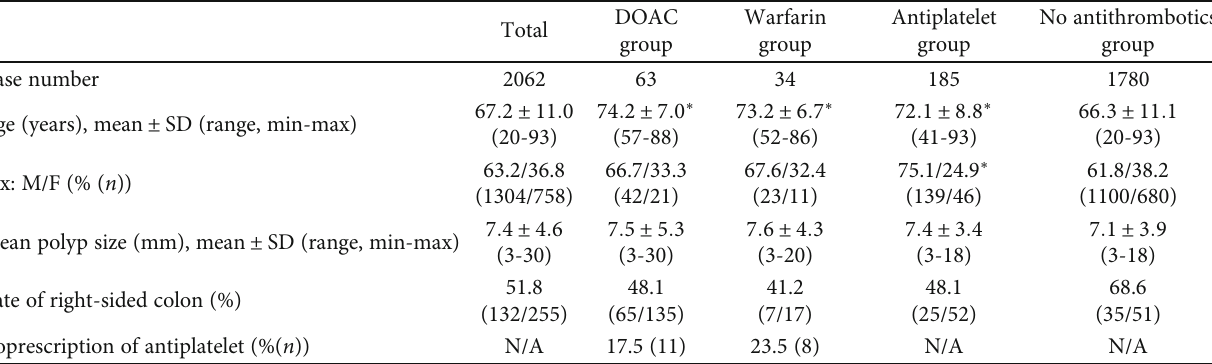
Table 1: Clinical characteristics of patients receiving endoscopic mucosal resection in the DOAC, warfarin, antiplatelet, and no antithrombotics groups.